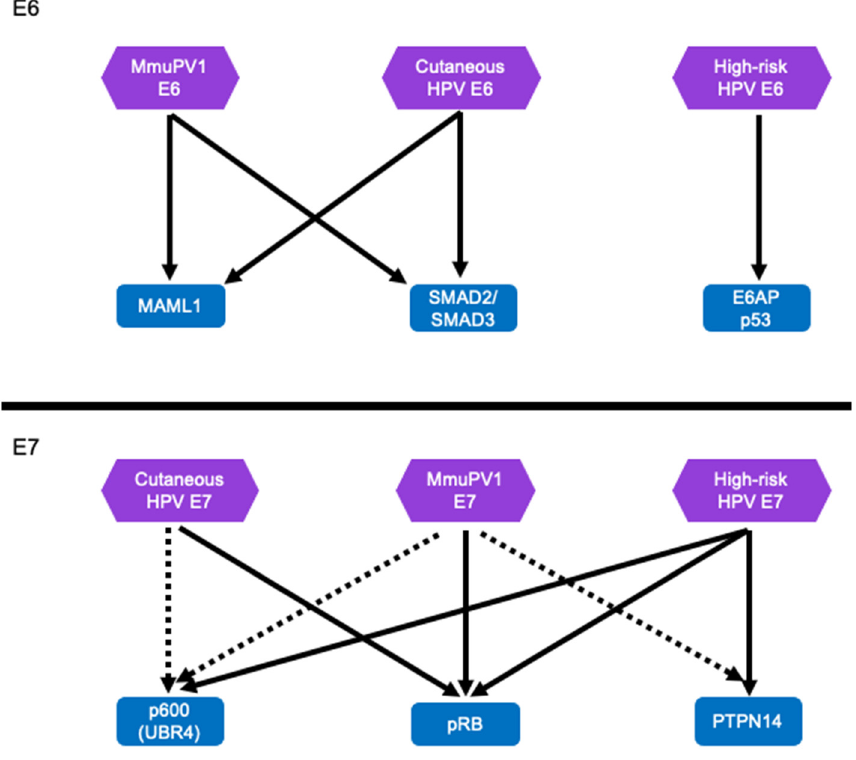
Figure 5. MmuPV1 E6 and E7 and HPV E6 and E7 proteins appear to target similar cellular pro- teins and pathways. The MmuPV1 E6 protein targets MAML1 and SMAD2/SMAD3 to inhibit NOTCH and TGF- β signaling, respectively. The cutaneous β -HPV E6 protein target the same cellular proteins leading to similar cellular phenotypes including inhibition of keratinocyte differentiation. This is distinctly different from the high-risk HPV E6 protein which targets p53 for degradation. However, the outcome of p53 degradation by the high-risk HPV E6 may also cause inhibition of NOTCH signaling [66,67,83,185]. The MmuPV1 E7 and the HPV E7 proteins likely target similar cellular binding partners including pRB to promote efficient neoplastic disease. It is likely that MmuPV1 E7 protein also target several other well-known HPV E7 cellular targets including p600 (UBR4) and PTPN14. Well validated cellular interacting proteins are indicated with arrows, interactions tentatively identified by proteomic analyses are show indicated with dashed